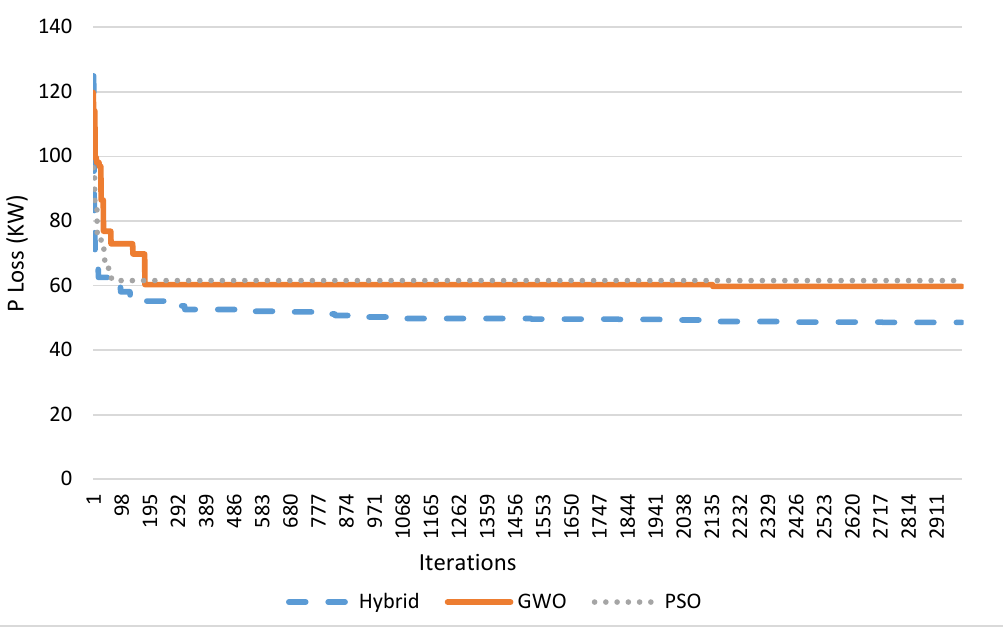
Figure 16. Conversion curve of the 78-bus system using three different methods for scenario 8. Table 9. Comparison of simulation results for PQ + -type DG units of the 78-bus system.